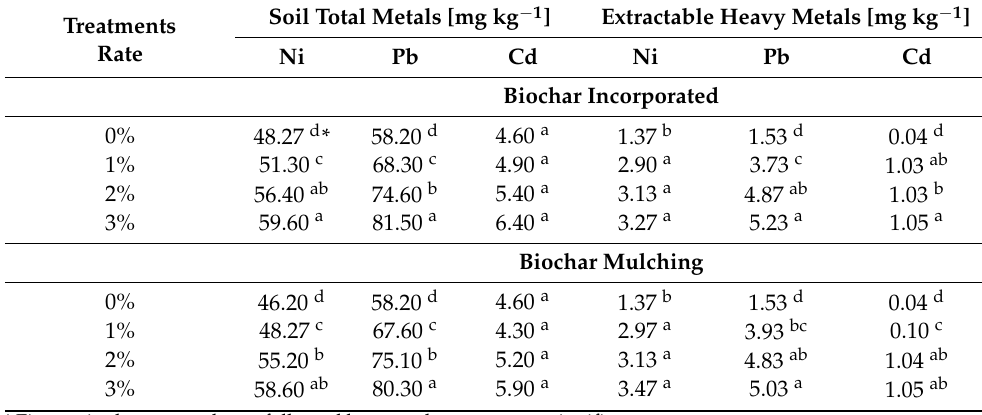
Table 7. Total and extractable heavy metals in the upper 20 cm soil as affected by biochar addition and drainage water